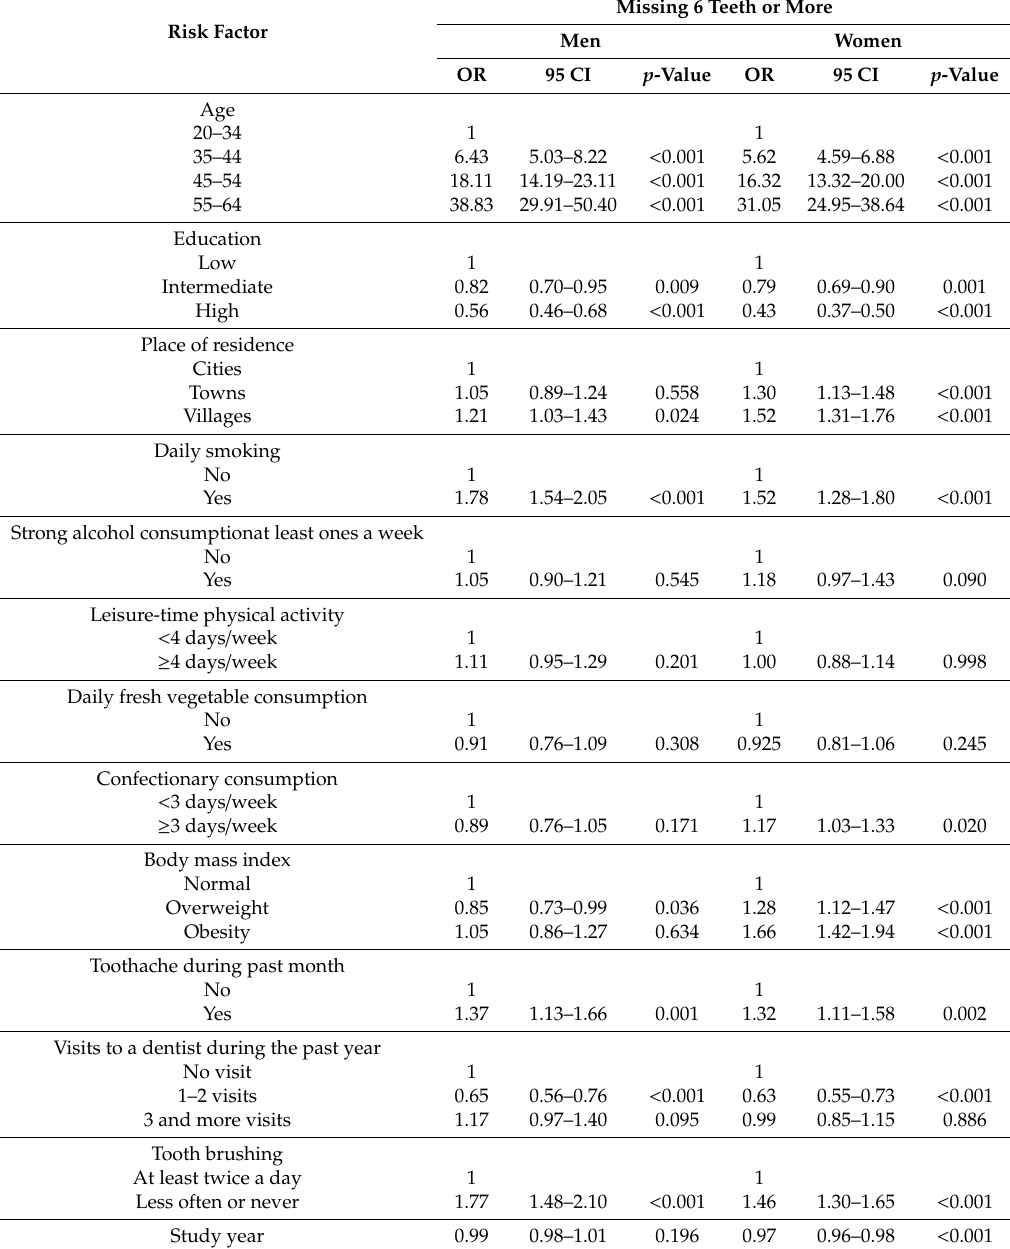
Abbreviations: OR—odds ratio; CI—confidence